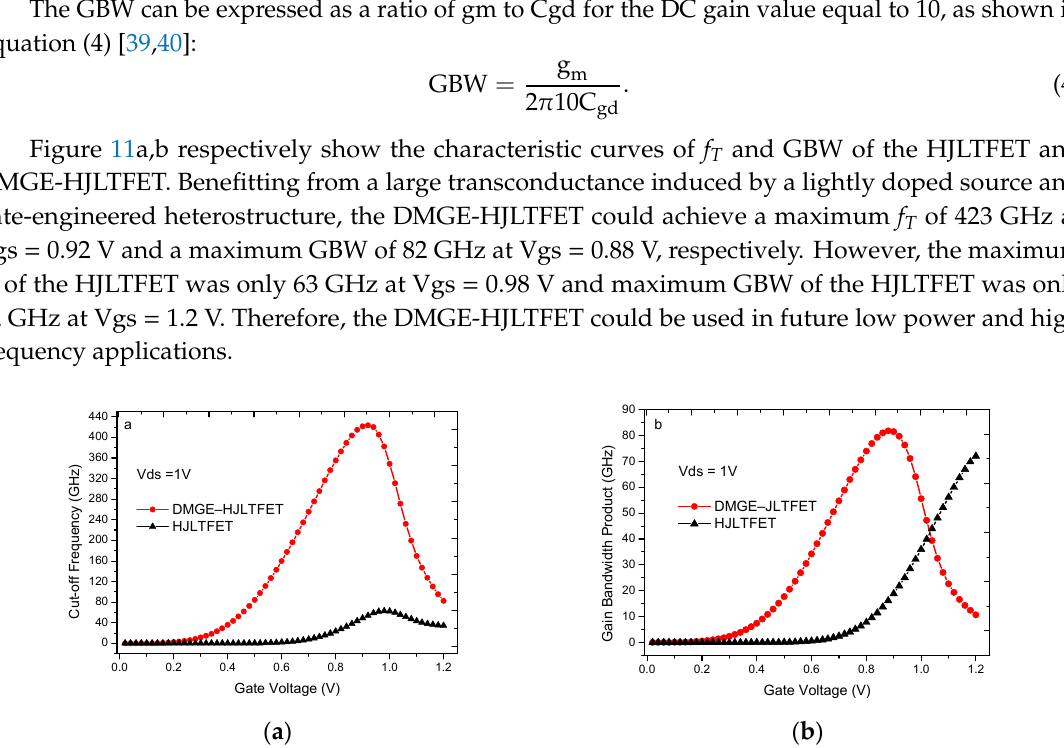
Figure 11. ( a ) The cut-off frequency ( f T ) characteristic curves of the HJLTFET and DMGE-HJLTFET; ( b ) the gain bandwidth (GBW) characteristic curves of HJLTFET and DMGE-HJLTFET.